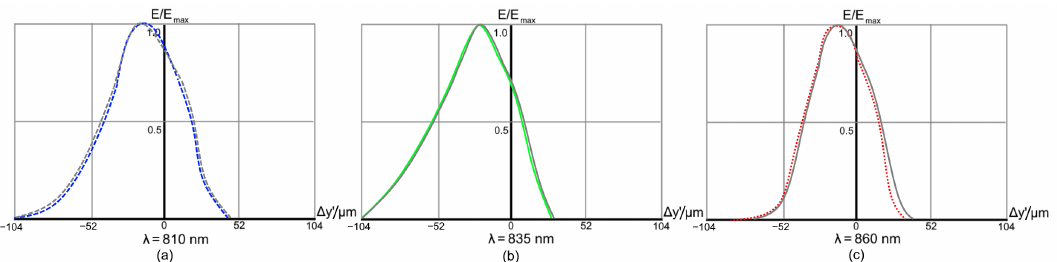
Figure 7. Instrument functions of the high-dispersion spectrograph Design A for a 50 µ m input fiber. The grey lines correspond to the design with flat